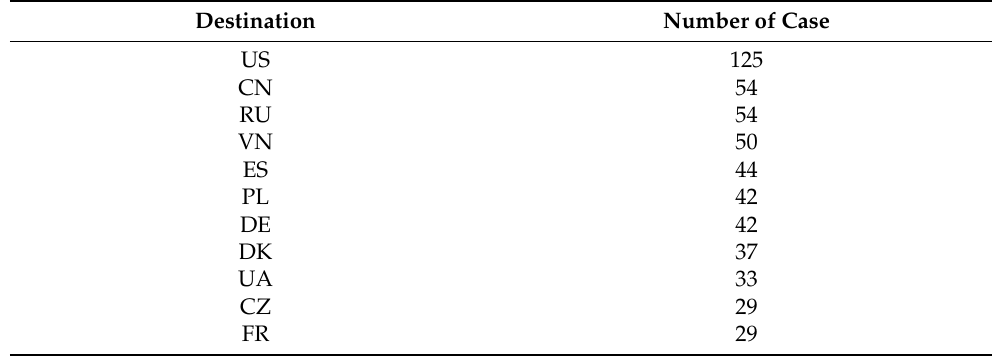
Table 2. The destinations and the number of trade cases of wild-sourced rhino for commercial, hunting, or personal purposes from South Africa.